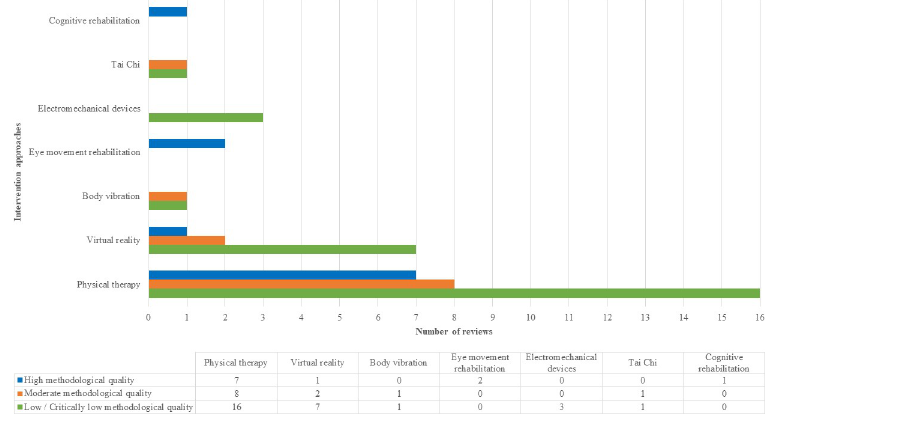
Fig 2. Methodological quality of each rehabilitation